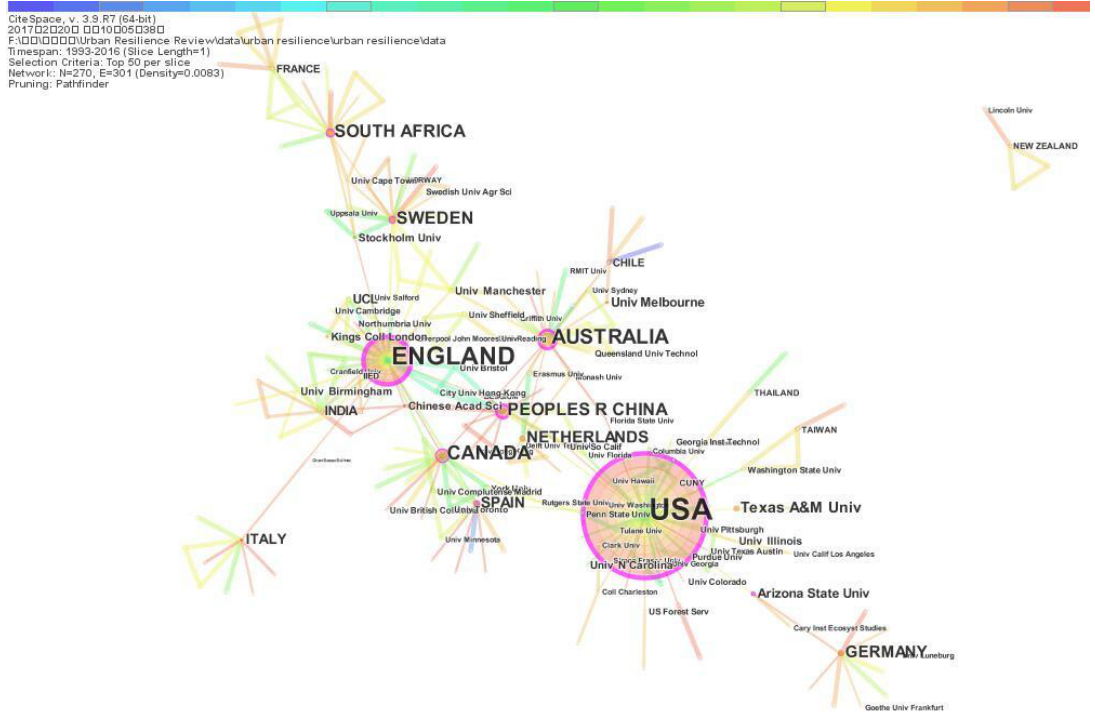
Figure 4. Collaborative relationship network.